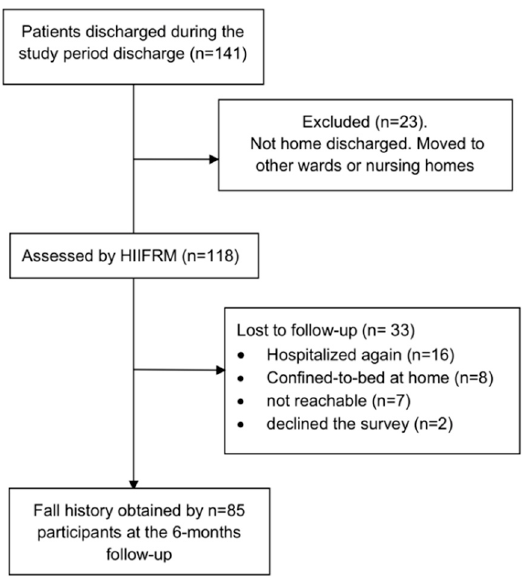
Figure 1. Flow diagram of patients assessed in the study from the date of discharge to the follow-up at the 6-month mark.